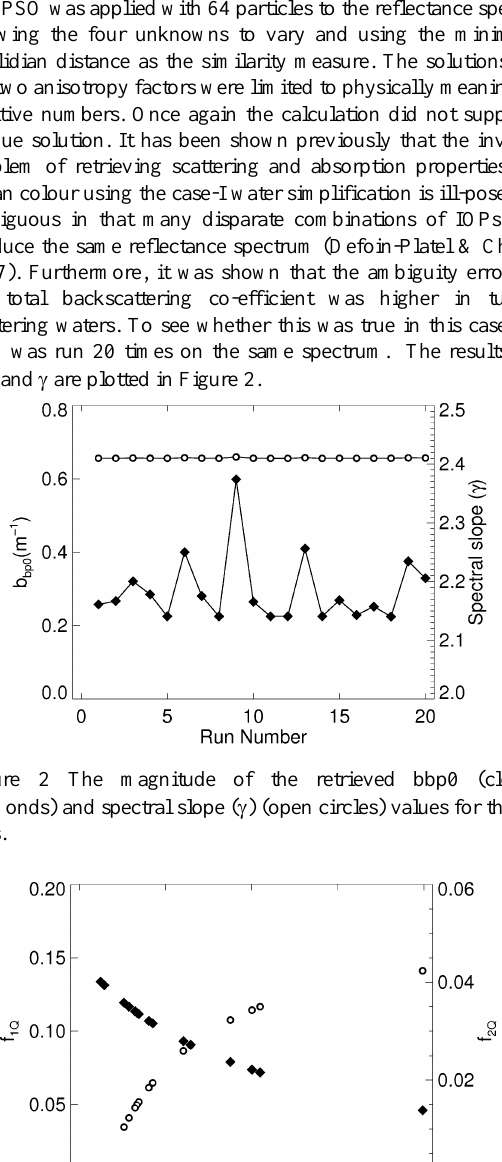
Figure 5 The Hydroscat-6 derived  vs. Reflectance derived  for the Burdekin Falls Dam stations. The dashed line shows a line of best fit for the data and the dotted line is a 1:1 correspondence